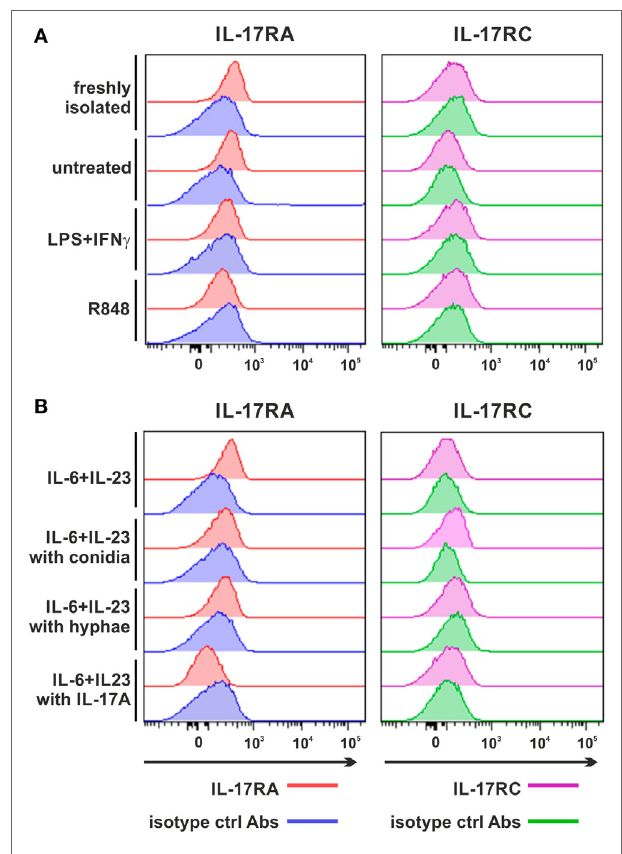
FigUre 4 | Expression of surface IL-17RA and IL-17RC in neutrophils activated under various experimental conditions. Expression of surface IL-17RA (left panel) and IL-17RC (right panel) was evaluated by flow cytometry in neutrophils either freshly isolated or cultured for 3 h without or with 100 U/ml IFN γ plus 100 ng/ml LPS, 5 µM R848 (a) , 20 µg/ml IL-6 plus 2 µg/ml IL-23 alone or in the presence of inactivated Aspergillus fumigatus conidia, hyphae or 500 ng/ml rIL-17A (B) . Graphs depict a representative experiment out of three independent ones with similar results. Histograms show staining by specific and isotype control Abs, respectively, for each stimulatory condition.